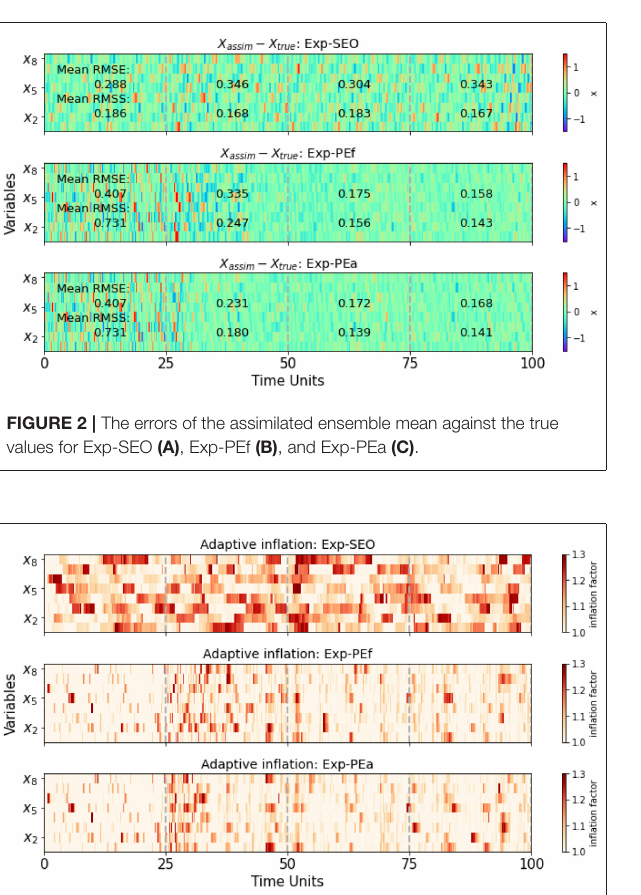
Frontiers in Climate |